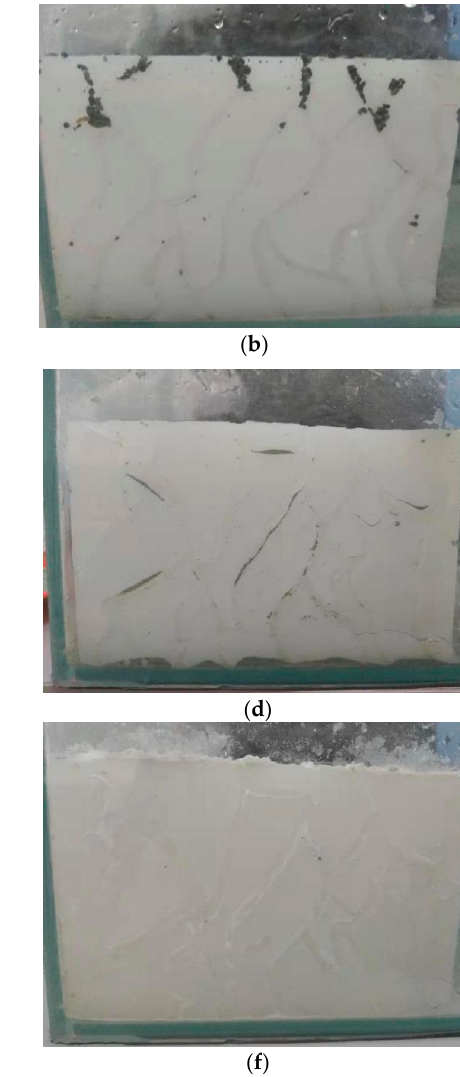
Figure 7. ( a ) 1.18 mm particle size or more ( b ) 0.6 mm–1.18 mm particle size. ( c ) 0.3 mm–0.6 mm particle size ( d ) 0.15 mm~0.3 mm particle size. ( e ) 0.075 mm~0.15 mm particle size ( f ) 0.075 mm or less particle size.